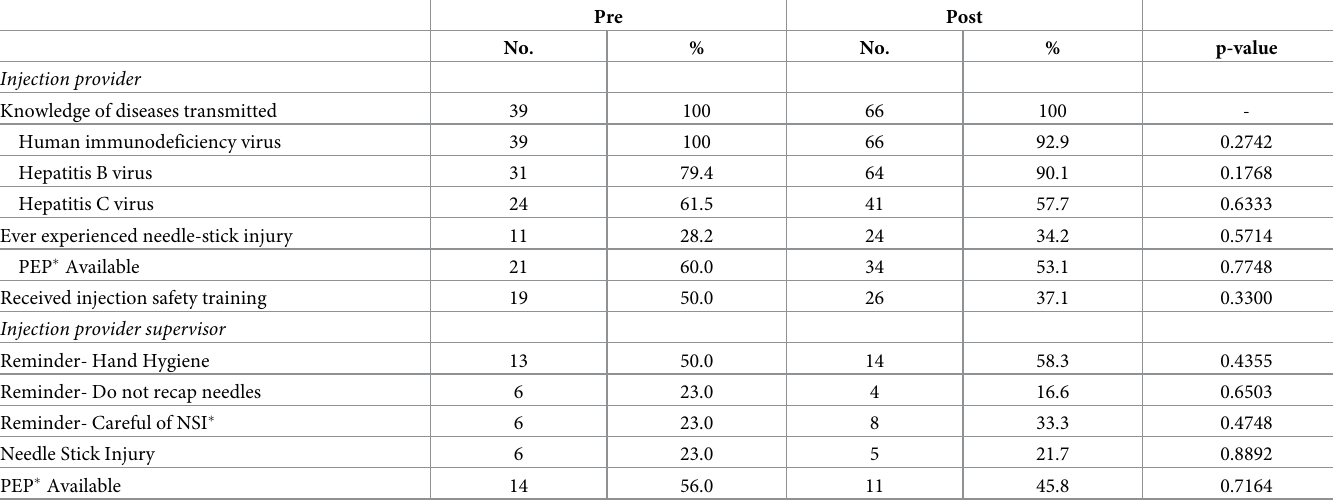
Table 4. Pre- and post-training assessment of healthcare worker knowledge and